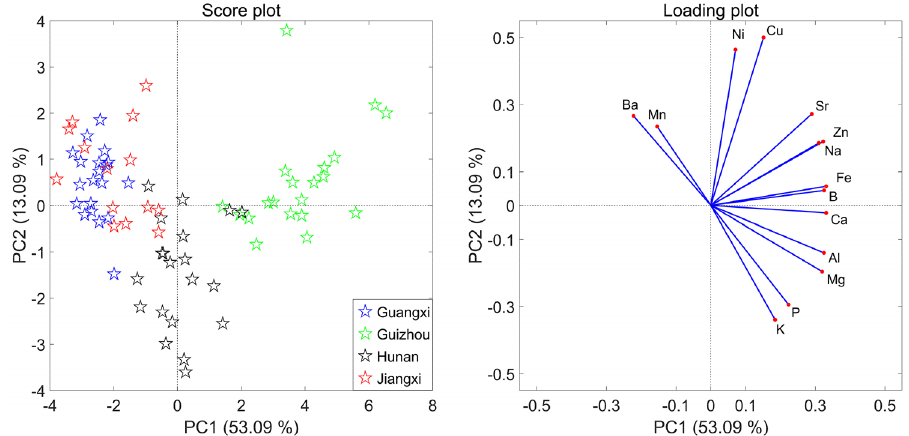
Figure 2. Score and loading plots of PC1 versus